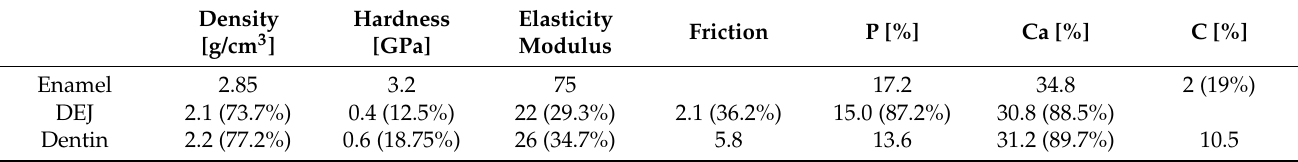
Table 1. Basic values of parameters for enamel, DEJ zone, and dentin; data for density adapted from Weatherell [35] and for hardness, elasticity modulus, and friction from Marshall et al.